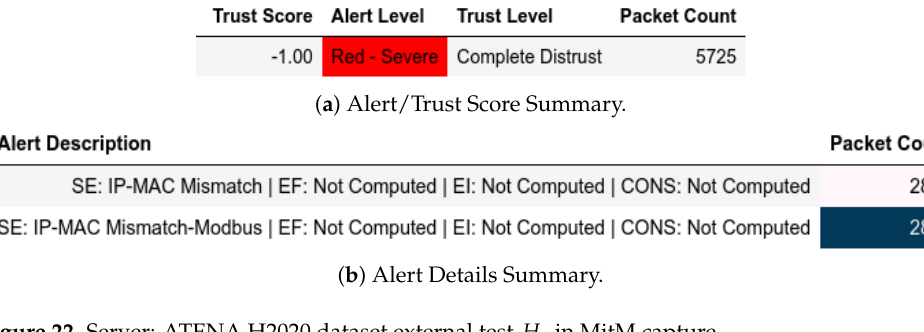
Figure 22. Server: ATENA H2020 dataset external test- H a in MitM capture.